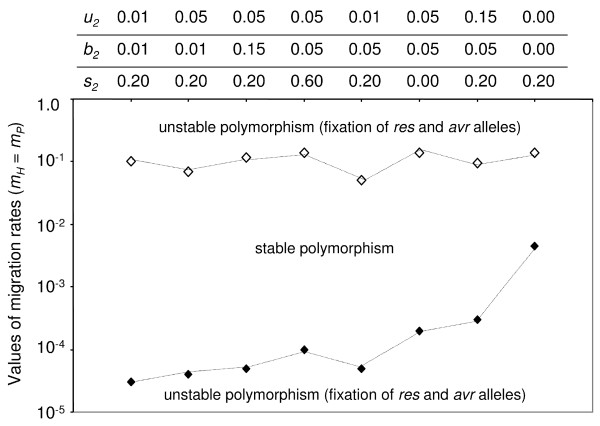
Outcome of GFG coevolution in a two-deme model linked by migration, in relation to the values of parameters in deme 2 (top lines for u2, b2 and s2) and migration rates (host and parasite migration rates are equal, mP = mH). The behavior of the system was investigated for fixed parameters in deme 1: u1 = b1 = 0.05 and s1 = 0.2), and was consistent for three initial frequencies of the resistant and virulent alleles (R0 = a0): 0.05; 0.1 and 0.2. When the migration rate had values below the black diamond, or above the white diamond, the host susceptibility and parasite virulence alleles became fixed. At intermediate migration rates, stable polymorphism in host and parasite populations was observed (for simplicity, c = 1).